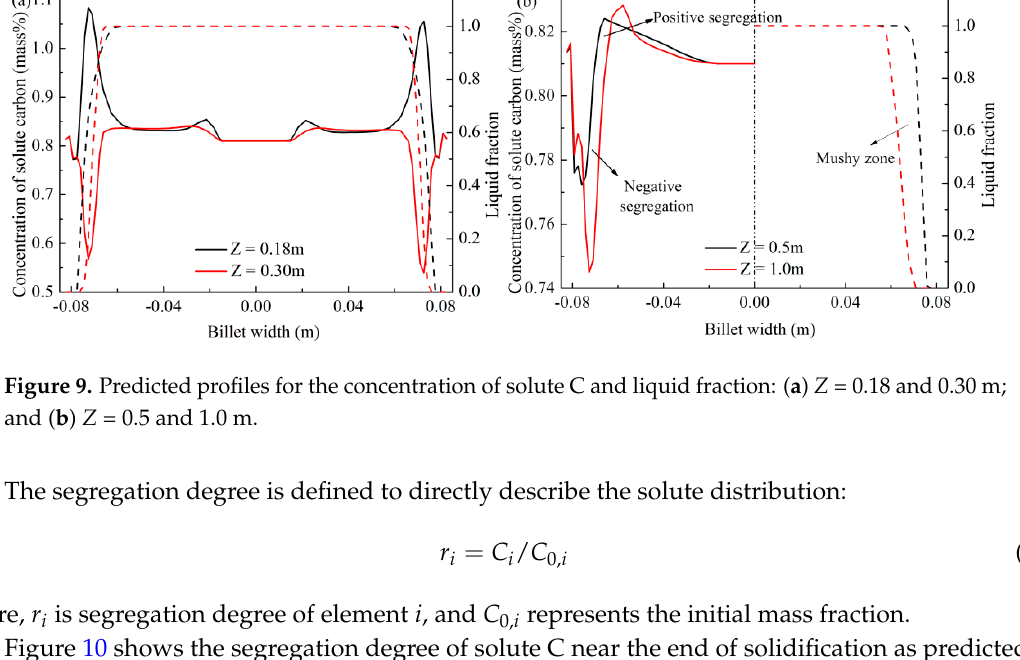
Figure 8. Detailed distribution of solute C in the mold.